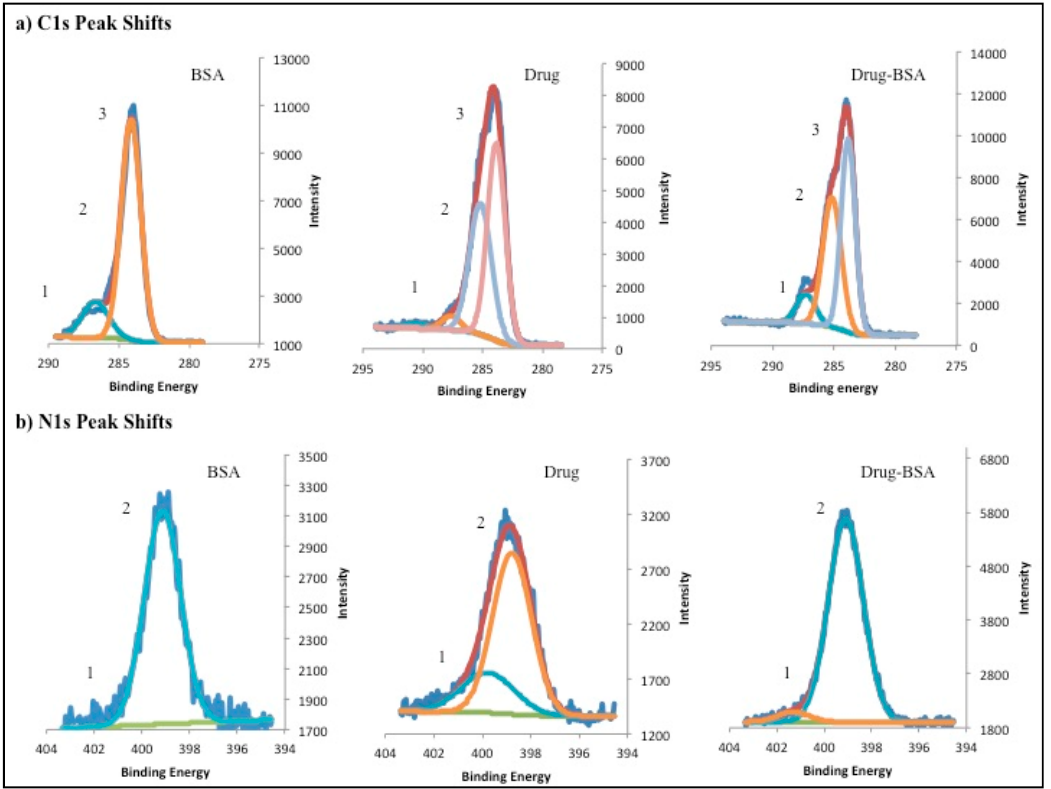
Figure 5. XPS spectra for carbon 1s (C 1s) and nitrogen 1s (N 1s) alterations in binding energy peaks for DNPs in comparison to native BSA NP and luminespib as control. ( a ) C 1s shifts also mark the presence of peak at second position for drug and DNPs whereas its absence in native BSA NPs; ( b ) N 1s peak shifts and the presence of peak at position one for drug and DNPs whereas its absence in native BSA NPs. Peak fitting function by multipack software, helps in identification of multiple peaks in the raw data. The sharp solid lines in above spectra represents peak fits for identification of single or multiple peaks in the wavy lines of raw data.